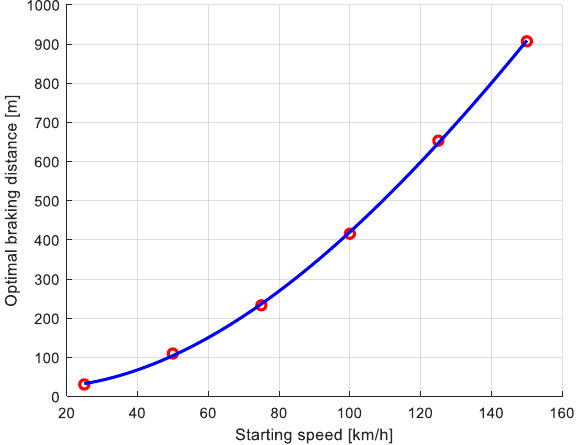
Figure 19. Optimal braking distance as a function of the starting speed.